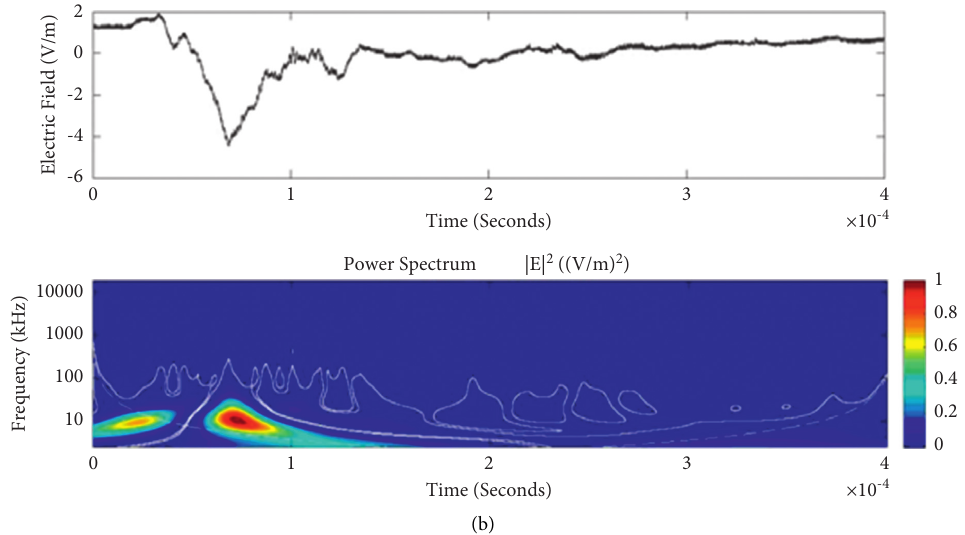
Figure 12: Example of the wavelet power spectrum of the first event (a) and second event (b) of the unusual lightning signal which is recorded as a flash number 20150416-0065 in Kathmandu, Nepal. The window size of the event is 400 μ